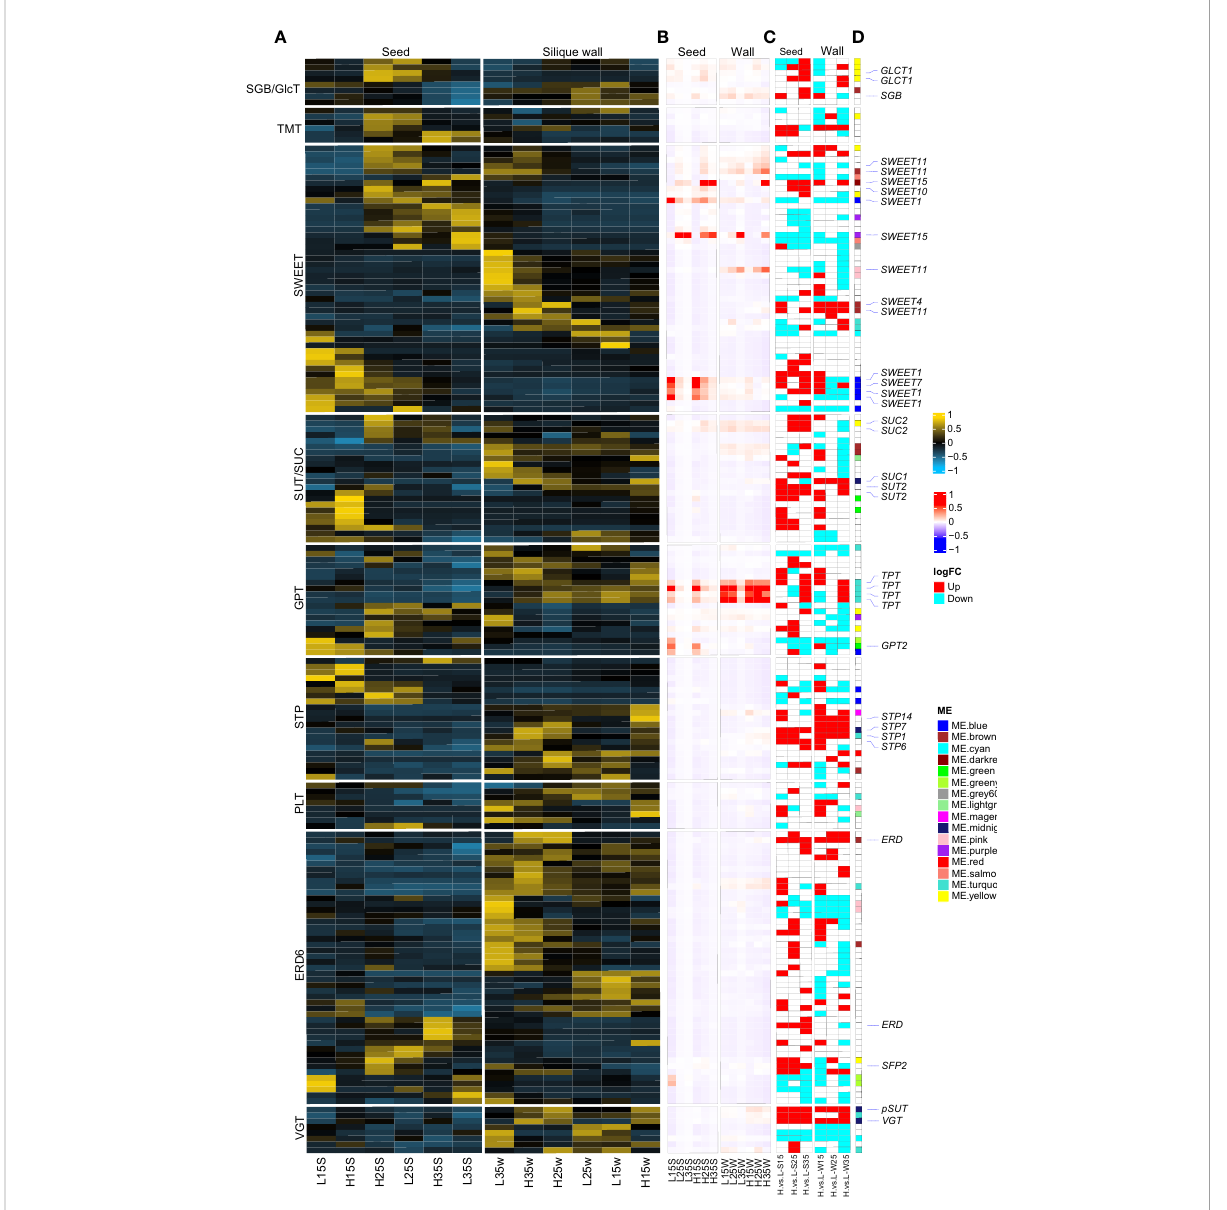
FIGURE 5 Differences of sugar transporters between L192 and A260. (A, B) heatmap of sugar transporters at the sample-wide level or gene-wide level according to the TPM mean of three biological replicates, respectively. (C) Difference in the expression of L192 versus A260. H, samples of L192 (high oil content). L, samples of A260 (low oil content). S, seed. W, silique wall. 15, 25 and 35, 15, 25 and 35 days after fl owering, respectively. H.vs.L-S, comparsion of L192 versus A260 in the seeds. H.vs.L-W, comparsion of L192 versus A260 in the silique walls. (D) Sugar transporters belonging to some modules according to WGCNA. Sugar transporters marked in the white block did not belong to any modules. VGT, vacuolar glucose transporter. ERD6, early response to dehydration 6, encodes a putative sucrose transporter whose gene expression is induced by dehydration and cold. PLT, polyol/monosaccharide transporter. STP, sugar transporter. GPT, glucose-6-phosphate/phosphate translocator. SUT/SUC, sucrose transporter/sucrose-proton symporter. SWEET, Sugar Will Eventually be Exported Transporter. TMT, tonoplast monosaccharide transporter. SGB/GlcT, suppressor of G protein beta/plastidic glycose translocator. TPT, triose-phosphate/phosphate translocator. pSUT, plastidic sugar